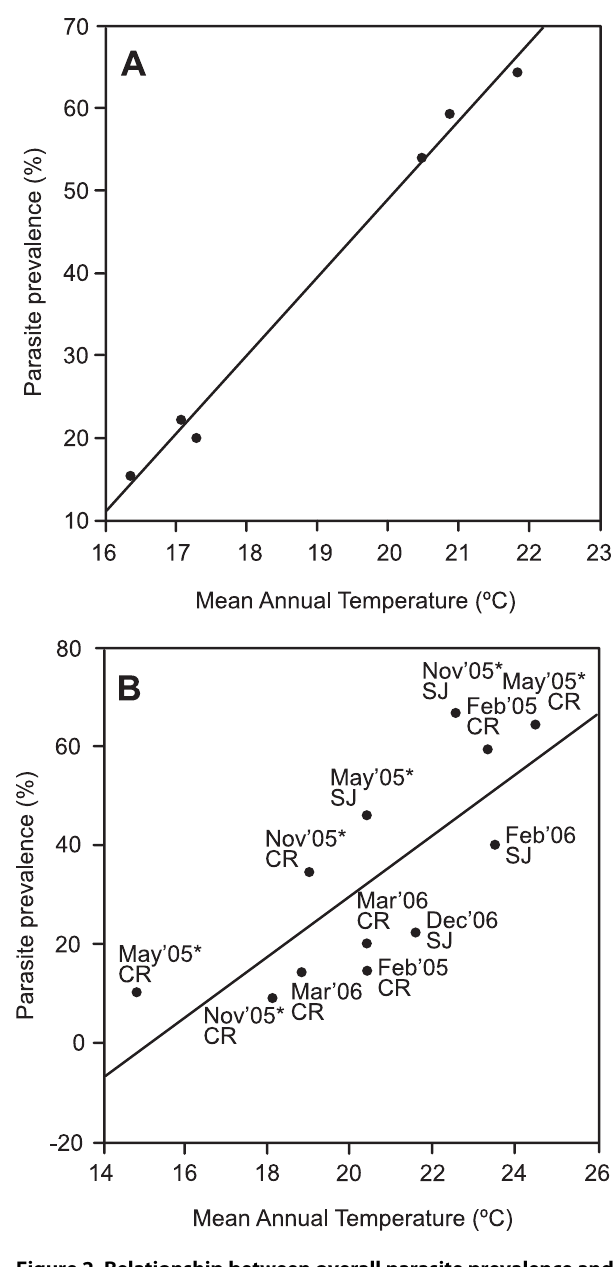
Figure 2. Relationship between overall parasite prevalence and temperature. Predicted variation of overall parasite prevalence as a function of a) Mean annual temperature and b) Mean monthly temperature. Month, year and locality (SJ = South Johnston and CR = Carbine Range) are indicated for each point. Dry season months are marked with